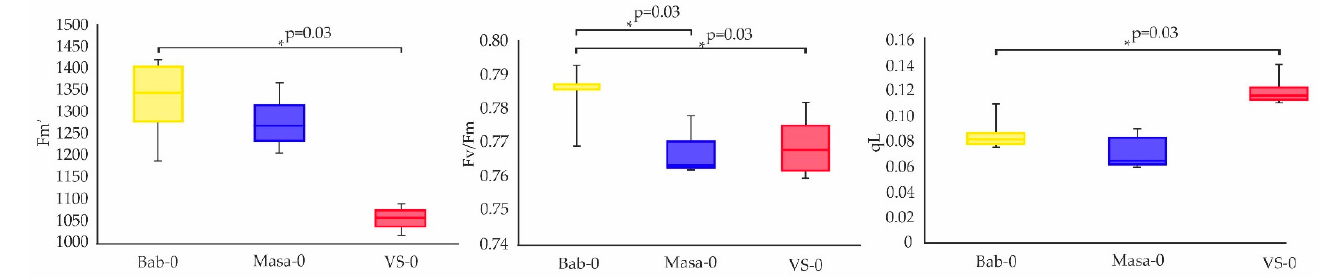
Figure 4. Parameters of photosynthetic activity of 17-day-old plants, grown from untreated seeds of accessions Bab-0 (Background), Masa-0 (Chronic LD), VS-0 (Chronic LD). Fluorescence was measured on the 17th day of cultivation in three plants per replicate for three biological replicates. Significant differences with exact p -values (Mann–Whitney U -test) are denoted by asterisk. The graphs were created using RStudio v1.4 (R-Tools Technology, Richmond Hill, ON, Canada). Photosynthetic parameters reflect the overall physiological condition of plants in the extreme environment [20], and chronic radiation exposure can influence them in a species- specific way [3]. Significant photosynthetic changes after acute high-dose γ -irradiation of seeds were found only for Bab-0 plants (Figure 5, measurements for other accessions are provided in Table S2). Maximum fluorescence levels Fm and Fm ′ in the dark-acclimated and light-exposed samples, respectively, as well as the minimal fluorescence yield in light- exposed leaves F0 ′ were significantly higher in plants developed from acutely irradiated Bab-0 seeds (Figure 5), probably pointing to slight stimulation of photosynthesis after acute irradiation.